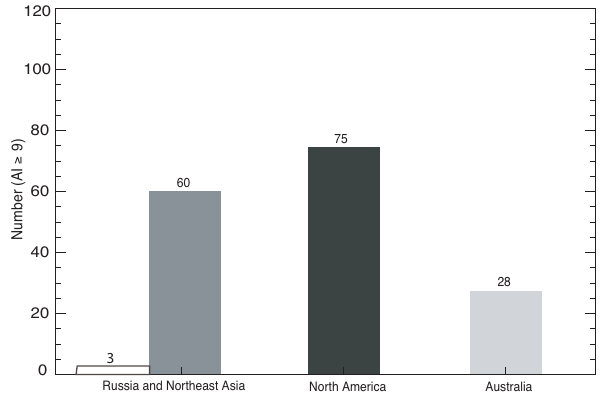
Fig. 6. Number of large-AI ( ≥ 9) observations over the three regions (shaded bars) shown in Fig. 5 during the entire AI data record. The white bar represents the number of dust plumes screened out over Russia/Northeast